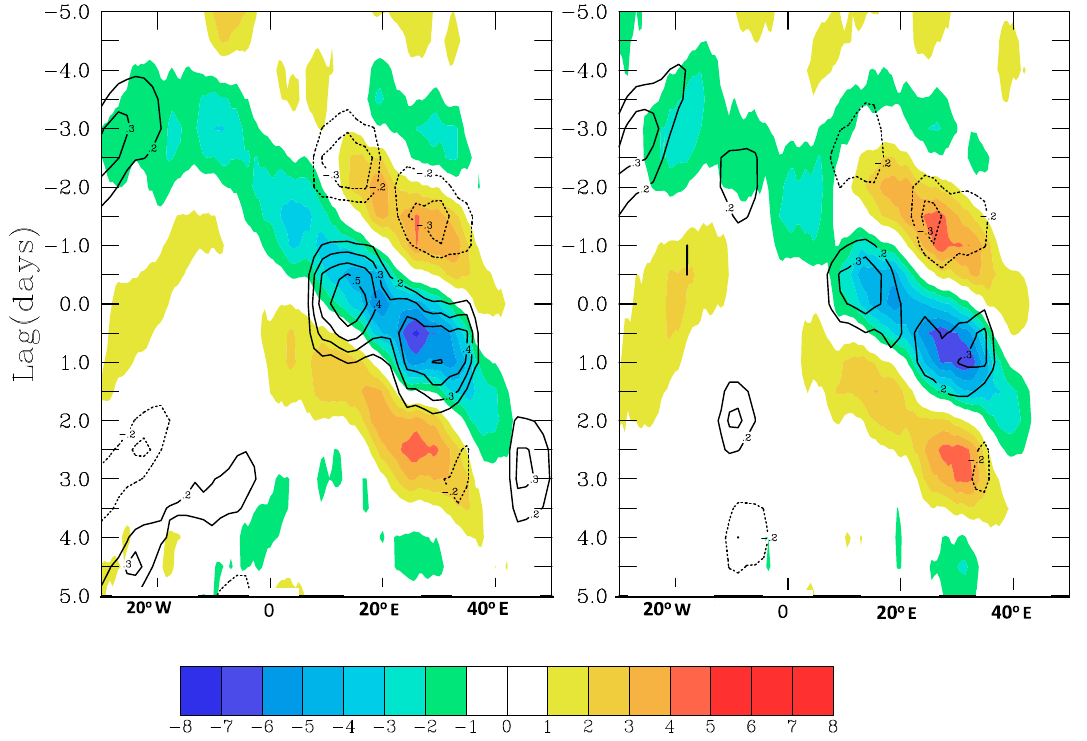
Figure 7. Kelvin wave regression composite anomalies of T B (shaded in K) and 850 hPa zonal wind (contoured every 0.1 m s − 1 ) for dry (left panel) and wet (right panel) years. Regression composites are averaged over 10°–12.5° N.